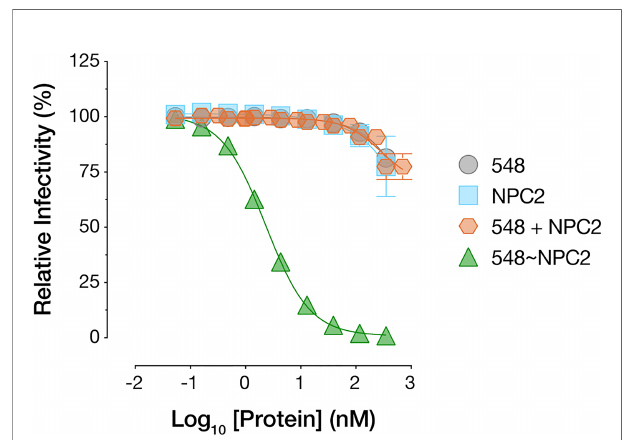
FIGURE 7 | NPC2 does not directly block viral entry. mAb-548, NPC2, equimolar combination of mAb-548 and NPC2, and 548~NPC2 bsAb were incubated with U2OS osteosarcoma cells for 2 h at 37°C prior to exposure to rVSV-EBOV GP. Infection was measured by automated counting of eGFP + cells and normalized to infection in absence of antibody or protein. Means ± SD are shown for four replicates from two independent